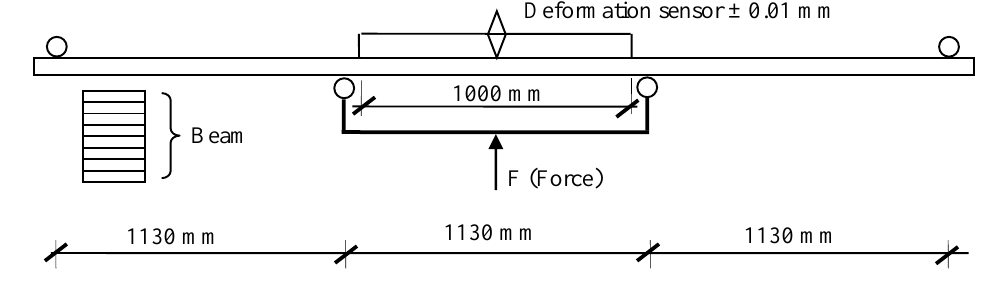
Figure 2. The scheme of the tested eight-layered beam.